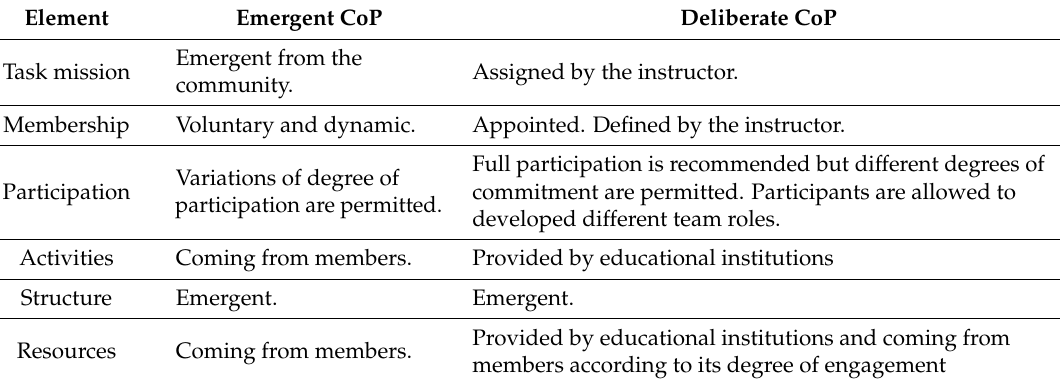
Table 1. Differences between emergent Community of Practice (CoP) and deliberate CoP in an educational